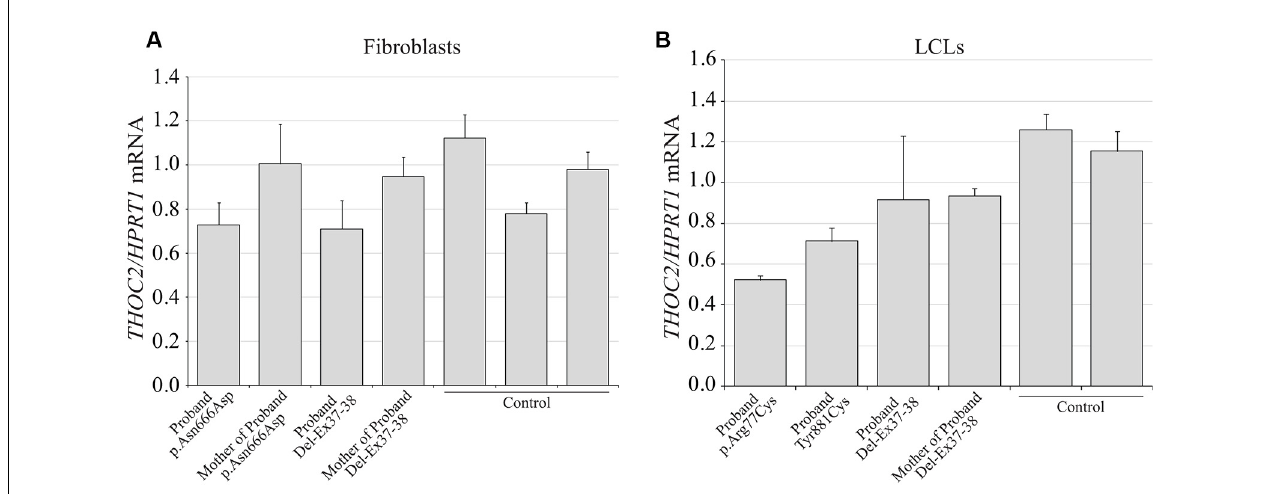
FIGURE 7 | THOC2 mRNA expression in the variant cell lines. cDNA was generated by reverse transcribing the total RNA extracted from variant fibroblasts (A) , LCLs (B) and appropriate controls using SuperScript IV reverse transcriptase and assayed for THOC2 expression (relative to HPRT1 housekeeping gene) with SYBR green master mix and primer pairs listed in Supplementary Table S1 . Assays were performed two times independently and error bars show SDs.